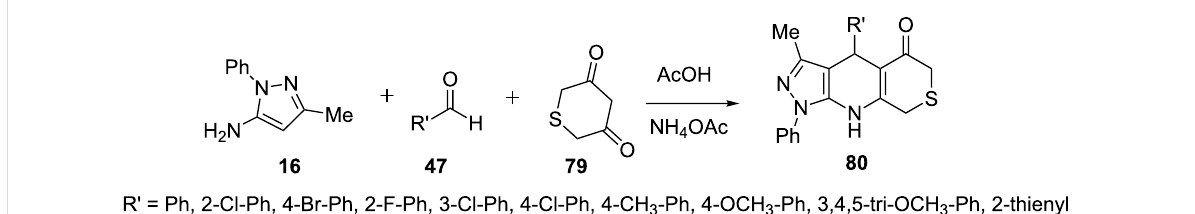
Scheme 20: Multicomponent synthesis of 4-aryl-3-methyl-1-phenyl-4,6,8,9-tetrahydropyrazolo [3,4- b ]thiopyrano[4,3- e ]pyridin-5(1 H